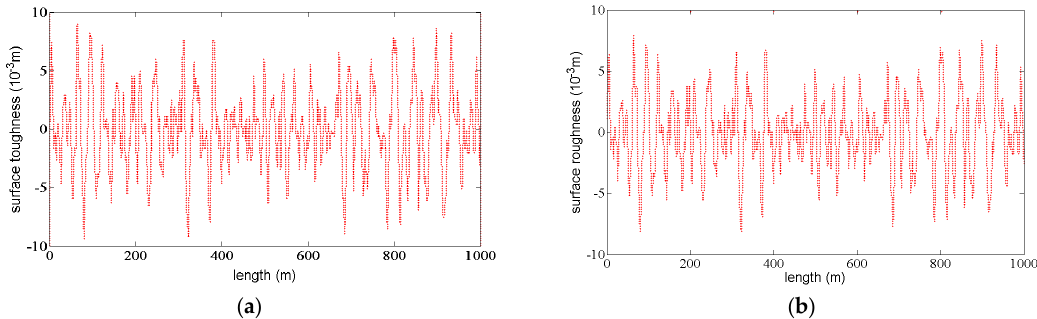
Figure 6. The surface roughness based on American six ‐ level track irregularity—( a ) vertical and ( b ) longitudinal.